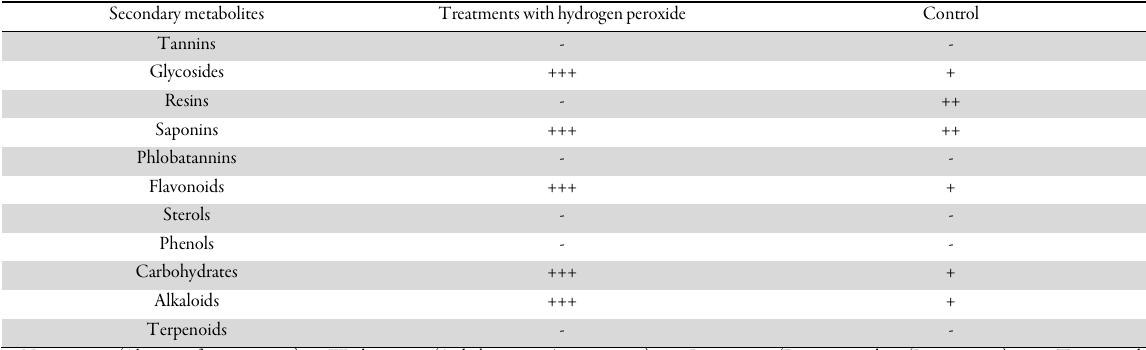
Table 1. Exogenous application of hydrogen peroxide on the of Vigna unguiculata Secondary